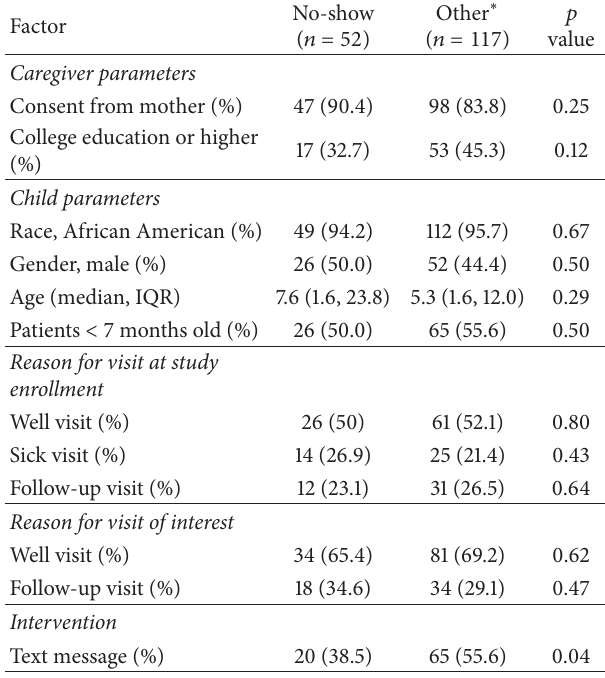
Table 1: Comparison of characteristics in outcome